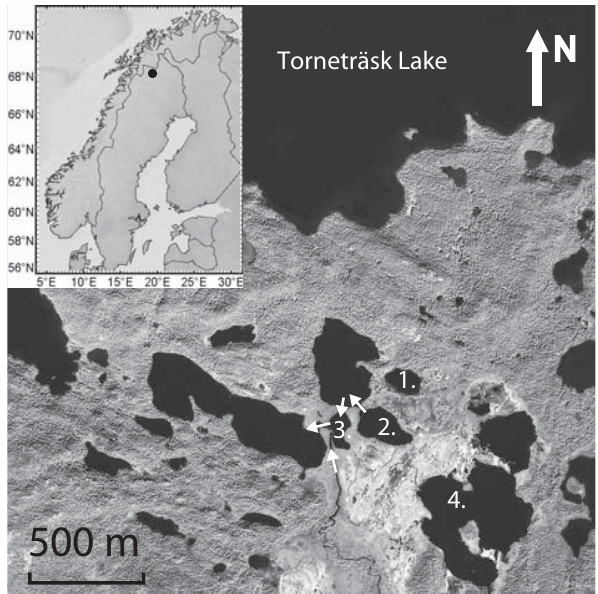
Fig. 1. Location map and lakes configuration (the arrows show wa- ter connections). The lakes are all embedded in a mire. lake 1, small and closed; lake 2, small and connected to another lake; lake 3, small, receiving water from a river to the South, connected to an- other lake to the North and draining into another lake to the West; lake 4, bigger and